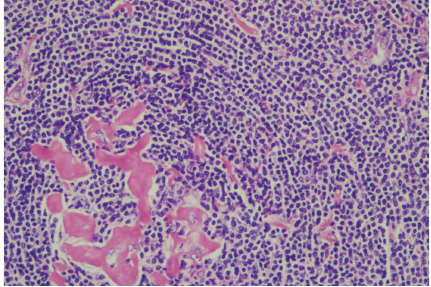
Figure 3: Hyaline-vascular Castleman’s